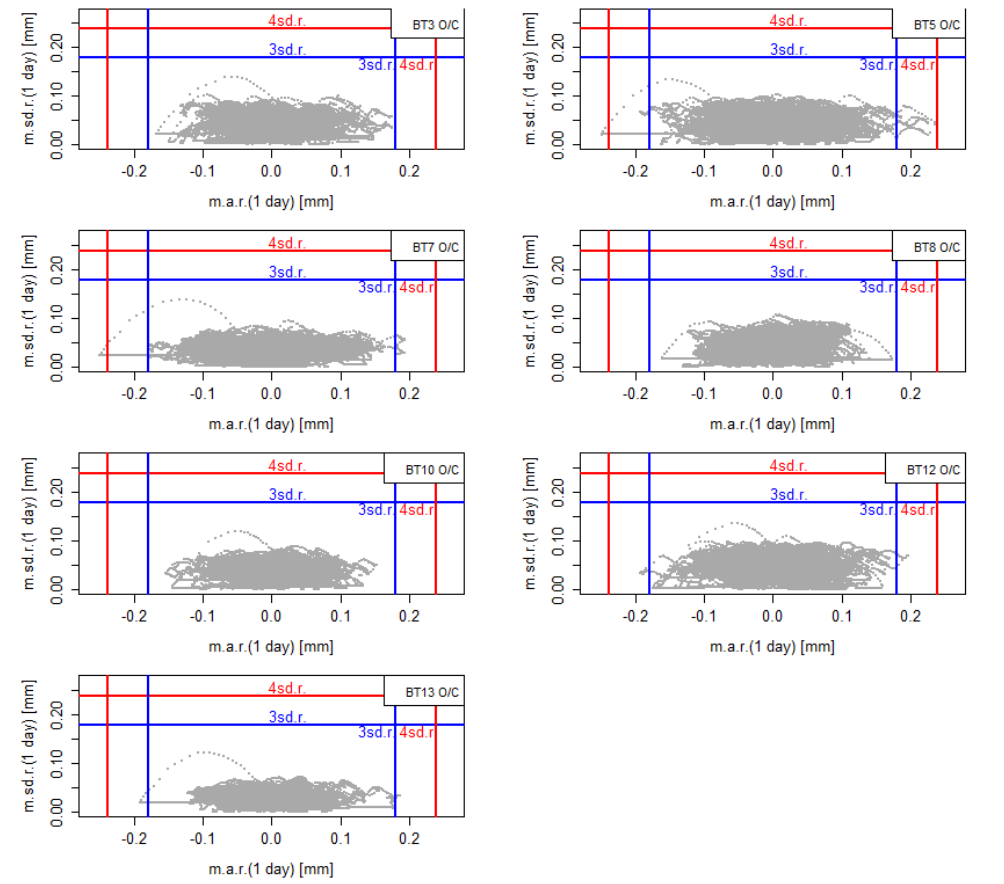
Figure 17. m . sd . r . vs. m . a . r . for each quantity.